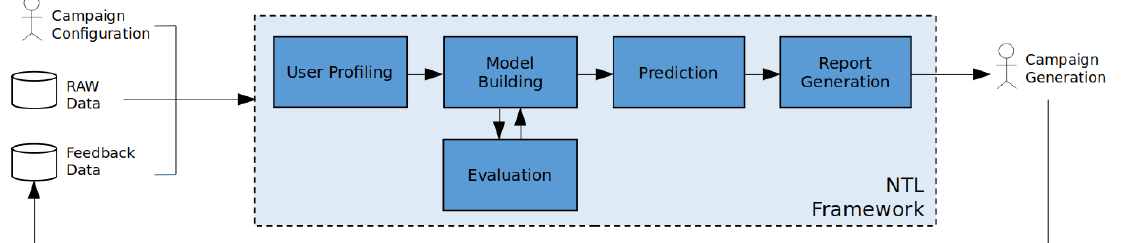
Figure 1. Structure of the NTL detection framework. The data is retrieved from different sources and used to build user profiles. Afterwards, a supervised model is trained to predict suspicious clients. With it, a report listing suspicious clients is generated. Finally, a new campaign is launched using the generated